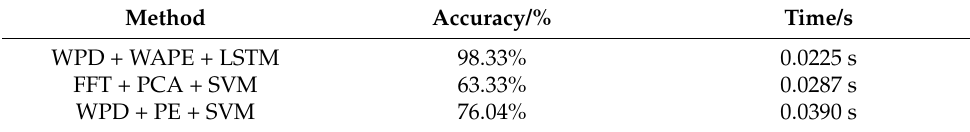
Table 9. Comparison of different methods for double-IGBT open-circuit faults.